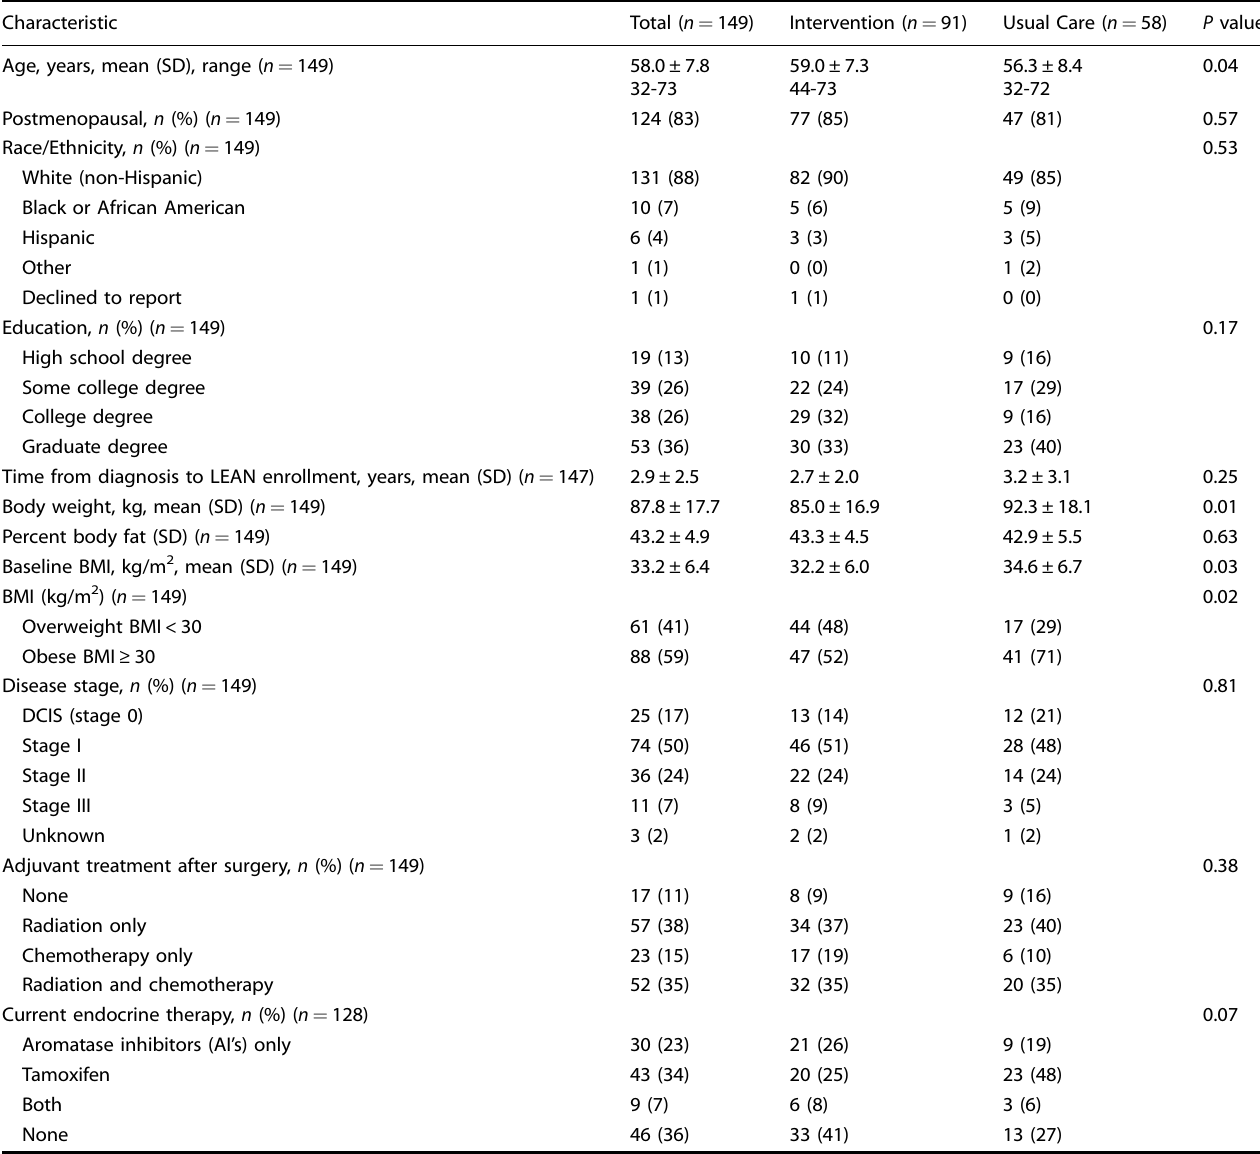
Table 1. LEAN 1 and LEAN 2 study participant